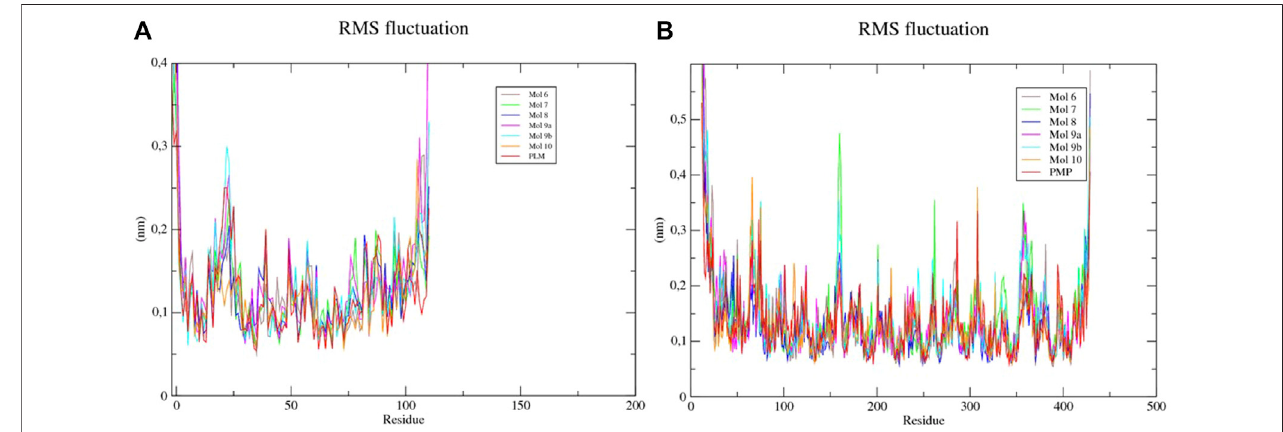
FIGURE 6 | RMSF of each amino acid of the (A) sterol-sulfated fl avonoids, (B) Kinurenine aminotransferase-sulfated fl avonoids and -PLM complexes.